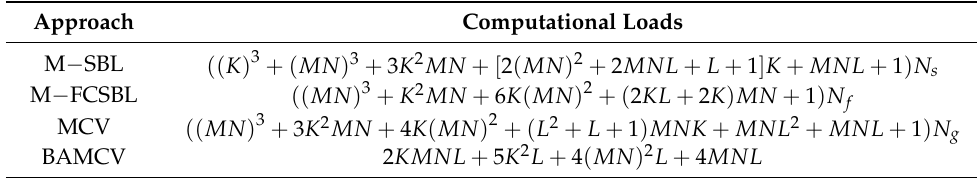
Table 6. Comparison of computational